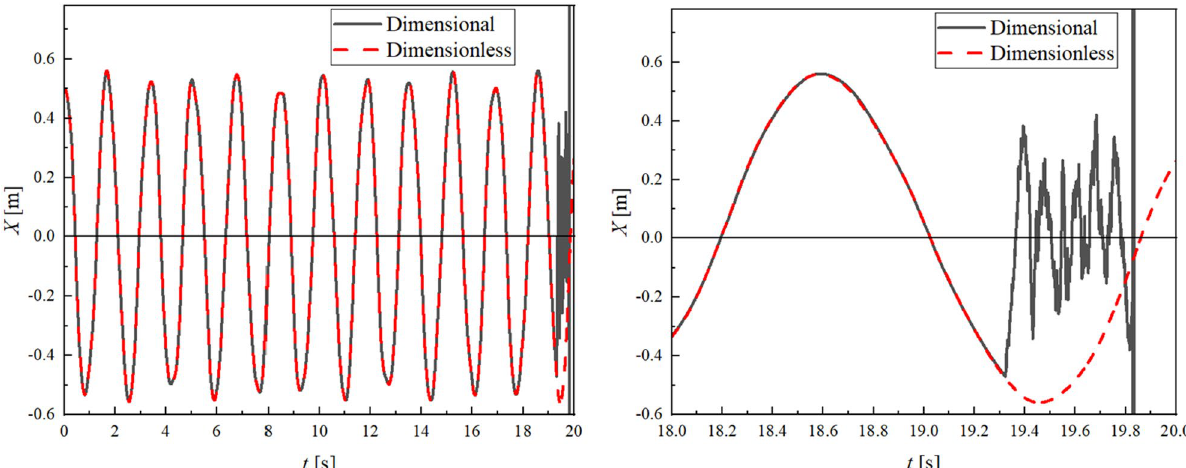
Figure 5. Time history of end point coordinate in X direction (left) and enlarged view (right). The dimensionless case maintains high accuracy compared to the dimensional case when a body length becomes shorter and the frequency becomes